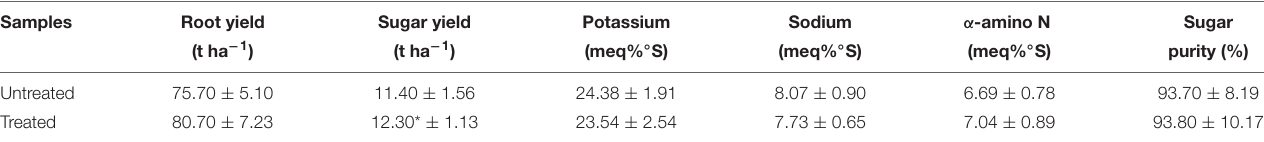
TABLE 5 | Mean of root yield, sugar yield, and processing quality-related traits in leonardite-treated and untreated sugar beet grown in Pozzonovo, Padua, Italy (45 ◦ 10’49.7”N, 11 ◦ 47’48.0”E). Samples